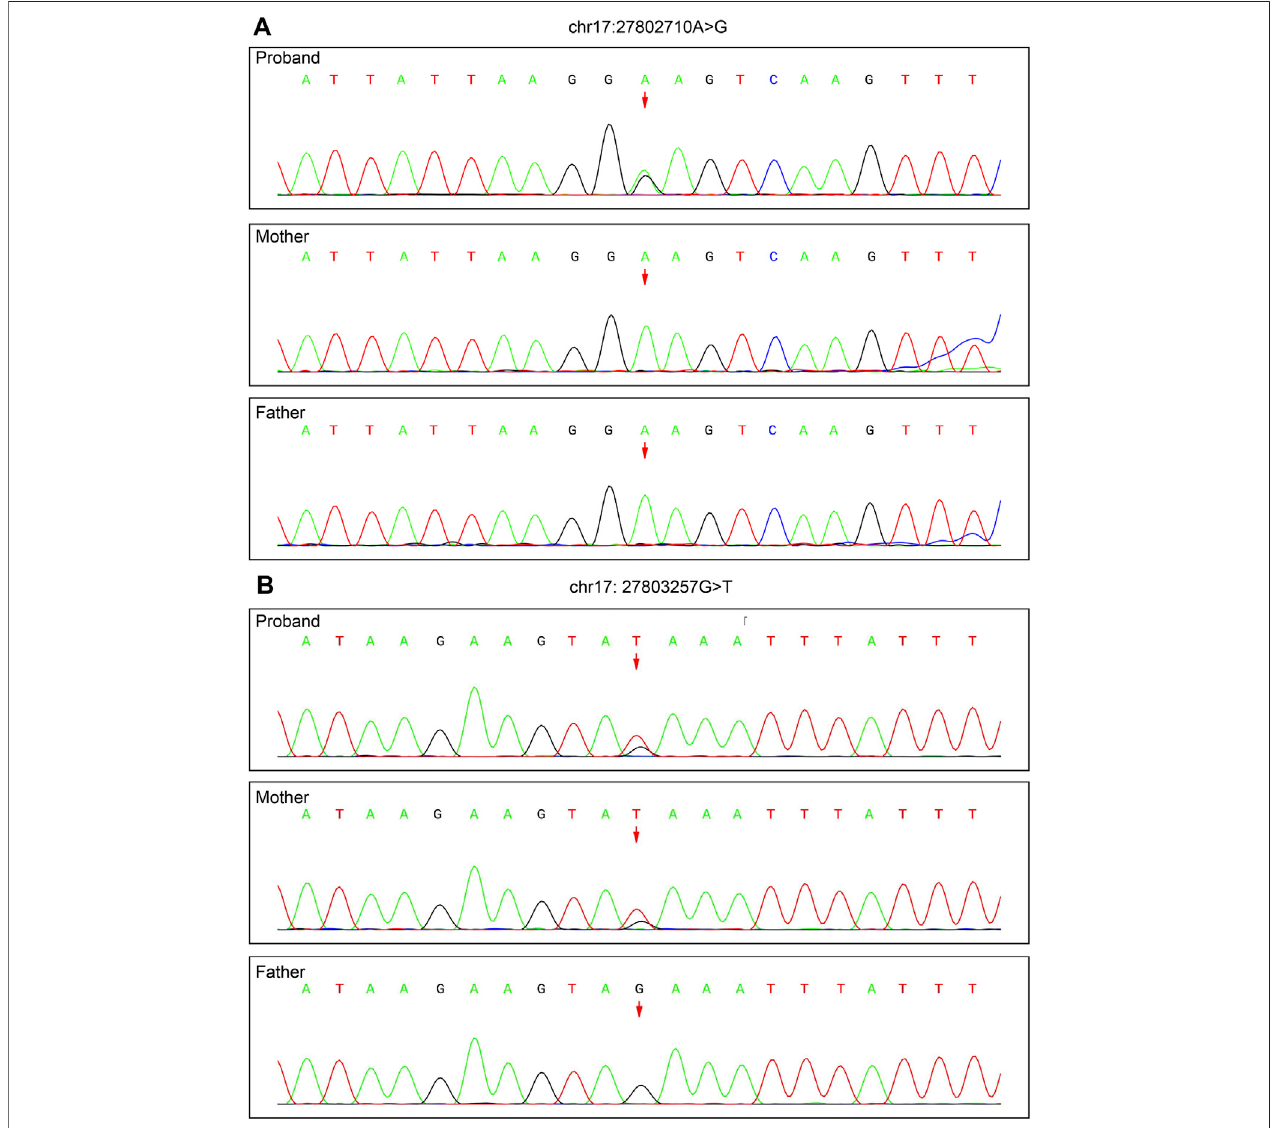
FIGURE 3 | Validation of the de novo variant c.227A > G of TAOK1 (chr17: 27802710) identi fi ed by trio WES and the reference variant c.306+468G > T (chr17: 27803257)identi fi edbyWGSbySangersequencing. (A) c.227A > Gwasfoundintheproband,butnotineitherparent. (B) c.306+468G > Twasdetected intheproband and mother, but not in the